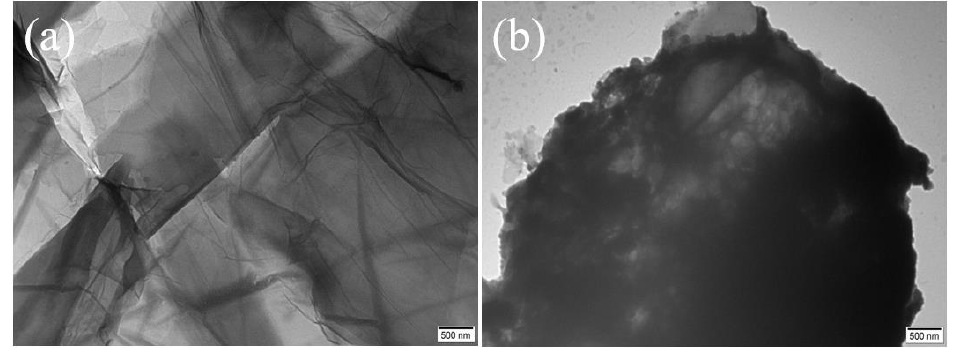
Figure 3. TEM images of the prepared GO sheets ( a ) and GO-MIPs ( b ).